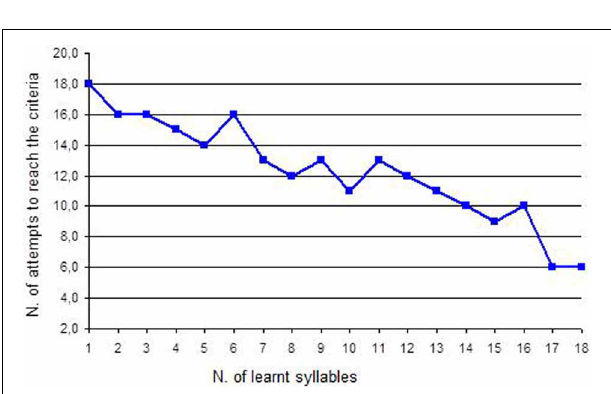
FIGURE 2 | Number of attempts to reach the criteria for each syllable.